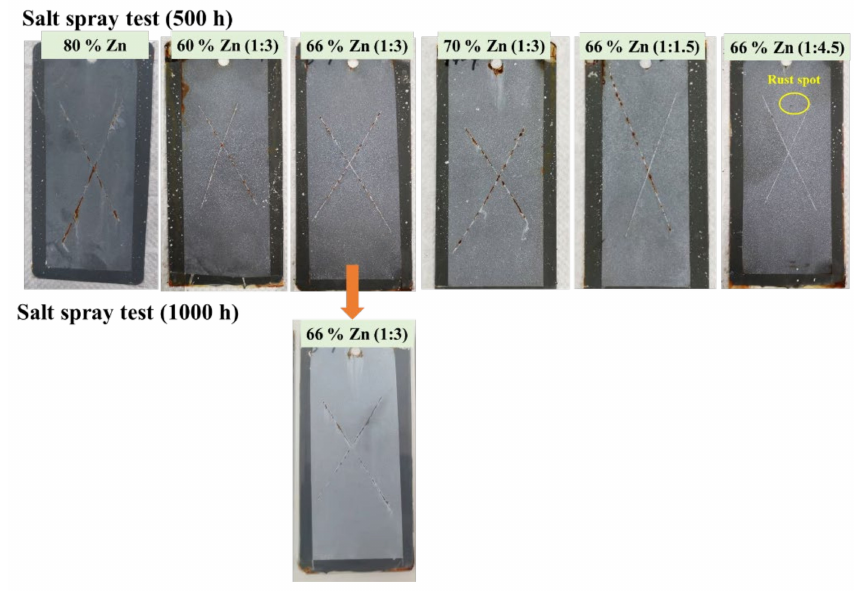
Figure 10. Surface appearance of thick ZRP coatings with different zinc content and replacing ratios of PPy/SCP particles after exposing to salt spray fog with 5% NaCl solution for 500 h–1000 h. Adhesion